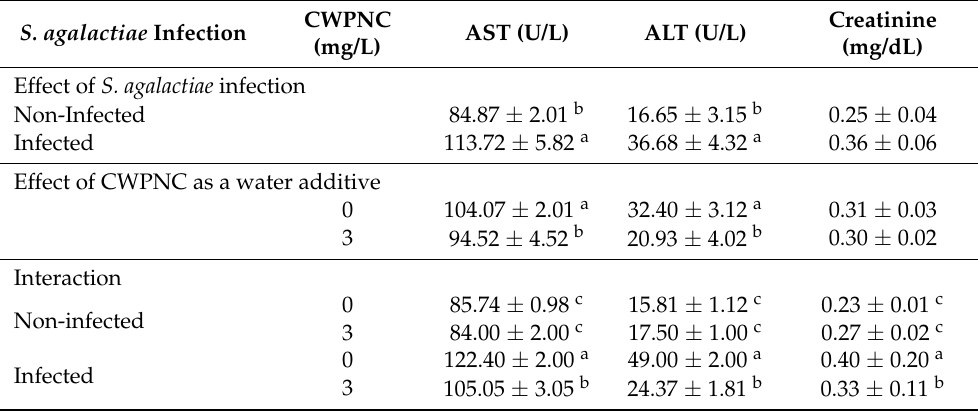
Table 6. Effect of S. agalactiae infection and/or CWPNC as water exposure on hepatorenal biomarkers of O. niloticus for seven